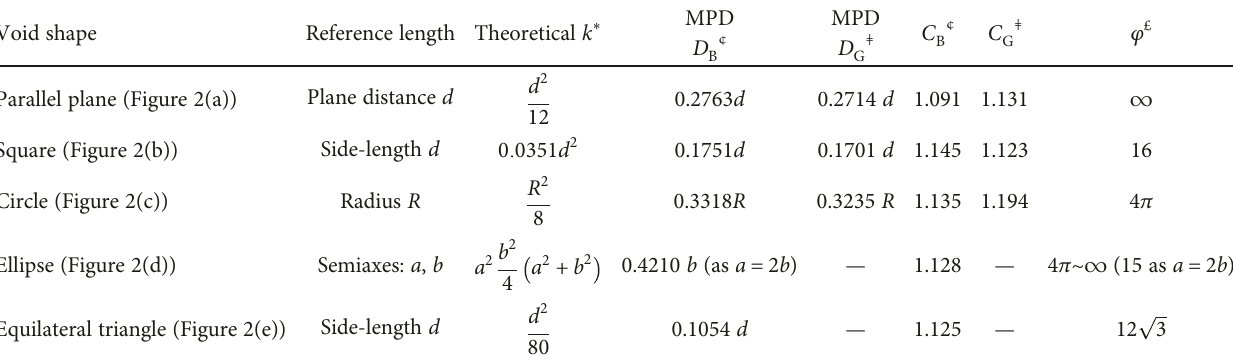
Table 1: Permeability, MPD, and C factor estimated by WOG and Green ’ s function for voids of simple geometries. Void shape